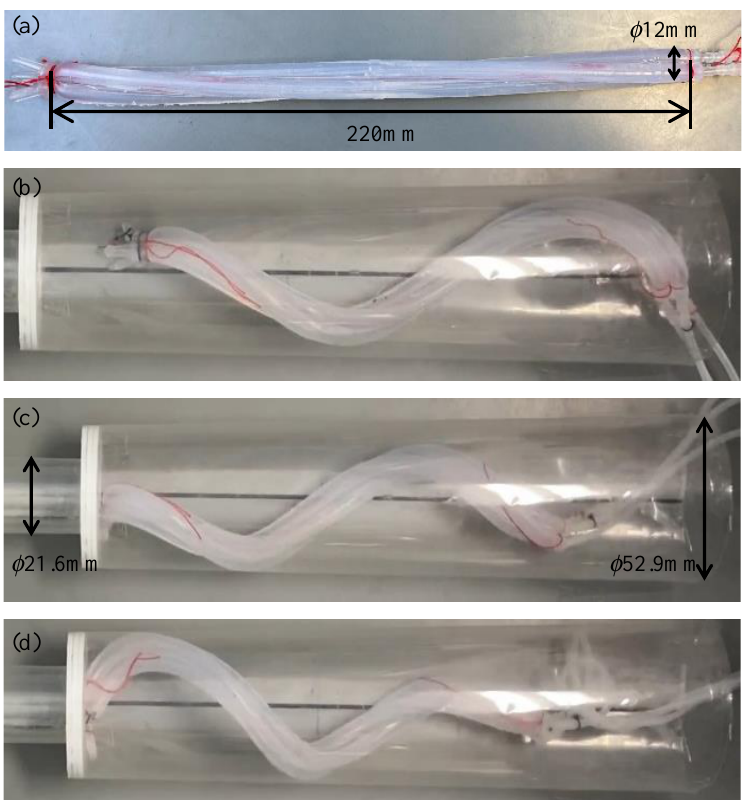
Figure 12. Experiment using a uniform pitch device. ( a – d ) show the initial shape, deformed shape, the moment when the front tip contacts the step, and the situation when the tip is caught by the step part,